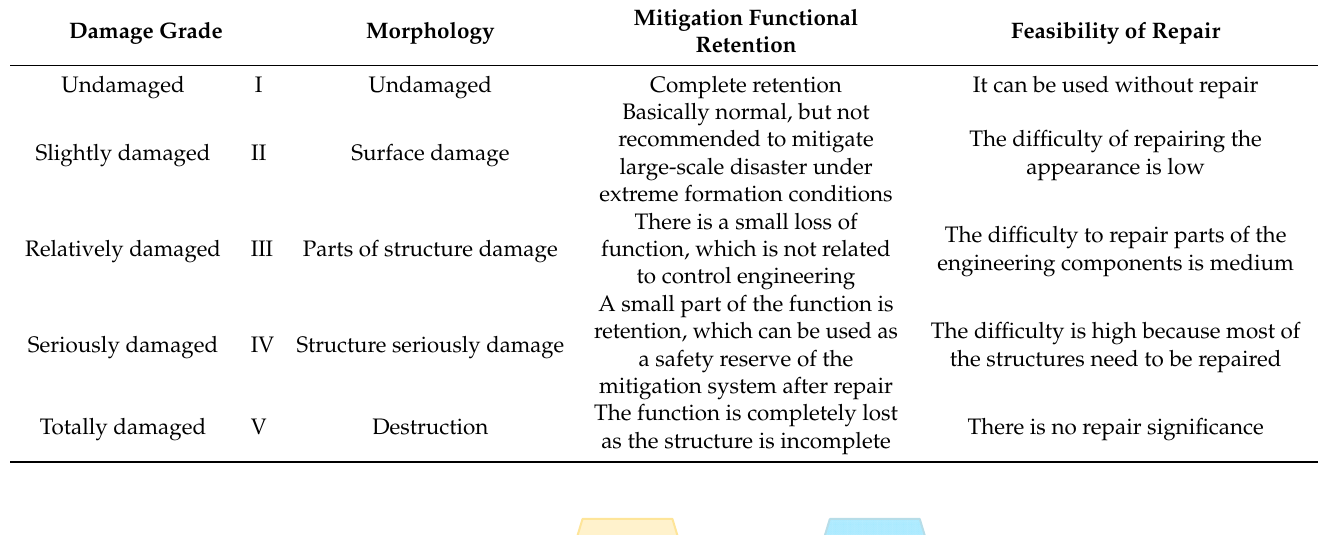
Table 1. The classification method of damage grade of engineering structure.